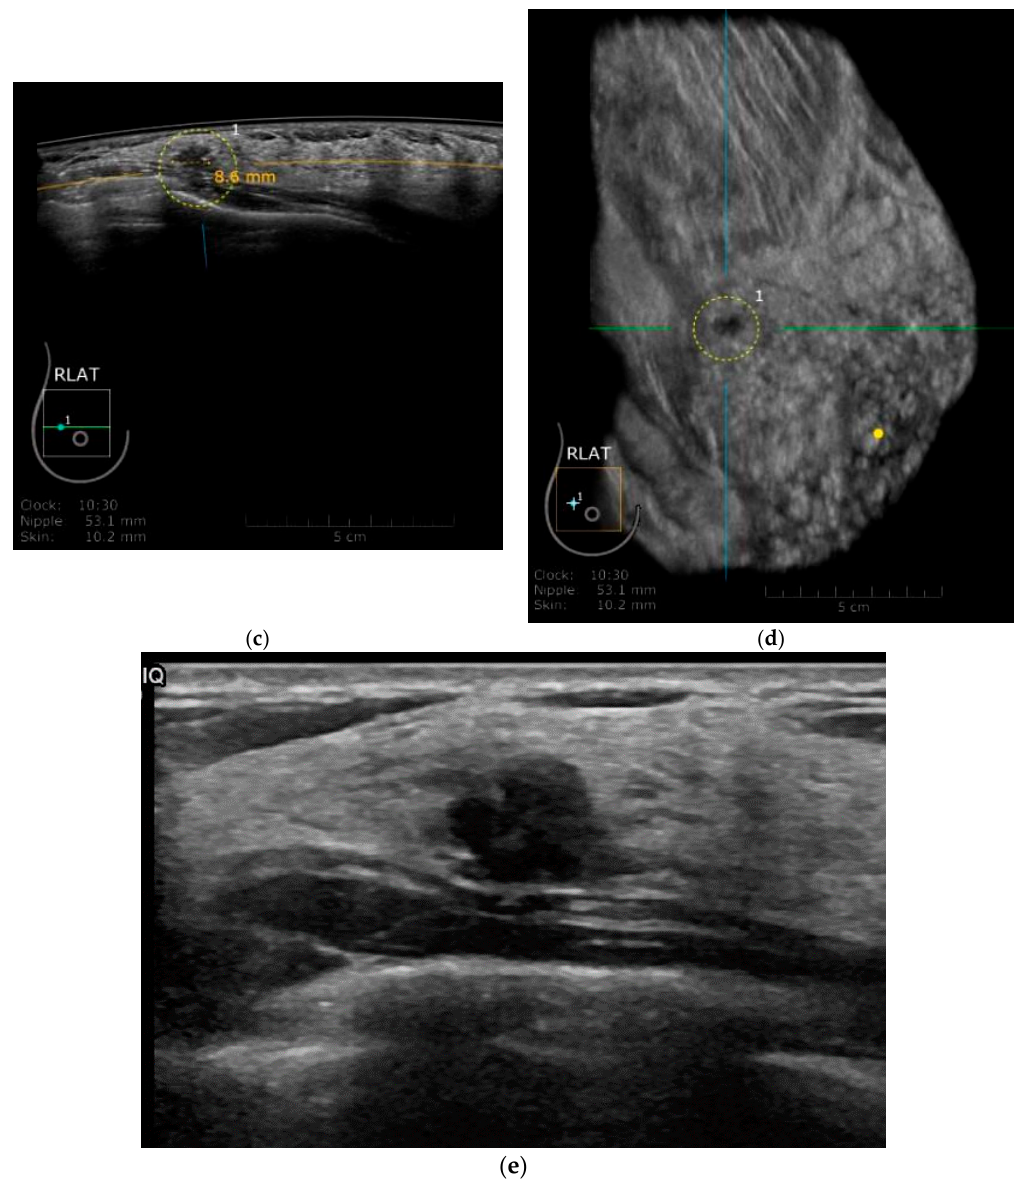
Figure 4. ( a , b ) CC and MLO digital mammograms in a 56 year old woman with heterogenously dense breasts with an occult breast cancer. Automated whole breast ultrasound (ABUS). ( c ) transverse image of ABUS and ( d ) reconstructed coronal image demonstrate an irregular hypoehoic mass. ( e ) Handheld ultrasound confirms a 0.8 cm irregular, heterogenous hypoechoic mass. Pathology demonstrated